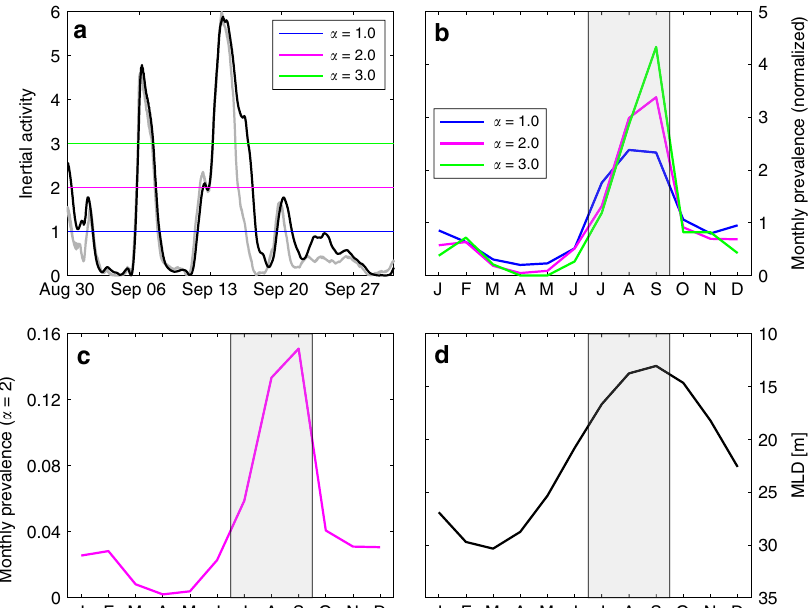
Fig. 6 Inertial activity evolution and monthly climatology at 11.5°N, 23°W. a Inertial activity (IA) index (gray solid line based on PIRATA winds at 11.5°N, 23°W, black solid line based on CCMP winds at the grid point 11.125°N, 23.375°W) from August 30 until October 1 including the observed near inertial wave event around September 15. The colored lines mark different thresholds α for IA. Gray shading highlights the boreal summer season July – September (JAS). b Seasonal cycle of monthly prevalence for IA (based on CCMP winds at the grid point 11.125°N, 23.375°W) crossing the different thresholds α , normalized by their respective annual means (0.14, 0.045, and 0.02) for comparison. c Seasonal cycle of monthly prevalence for IA crossing the threshold α = 2 (as in b ), but without normalization. d Seasonal cycle of the mixed layer depth (MLD) from ePIRATA at 11.5°N,